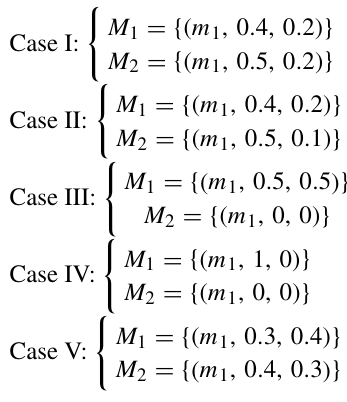
outperforms the majority of the available PF measures of